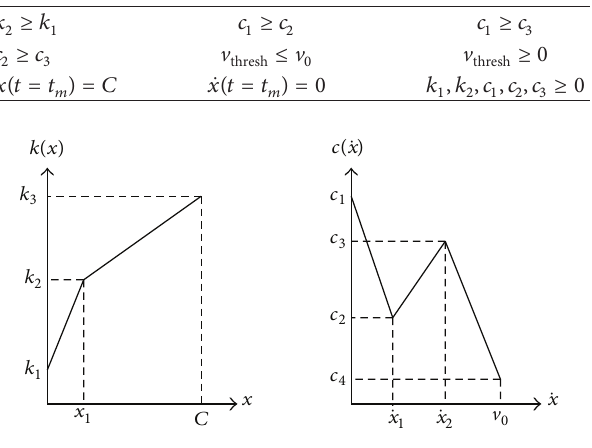
Figure 7: Spring and damper coefficient